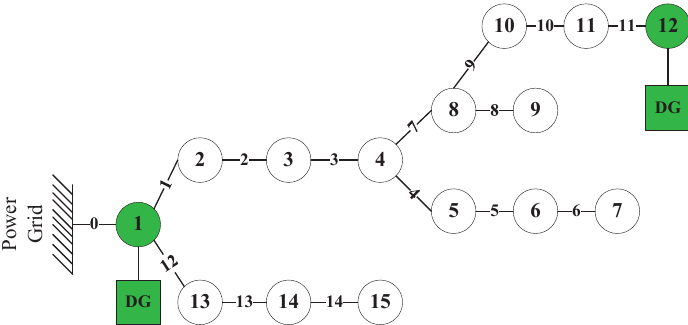
Figure 2. The 15-node network structure diagram.